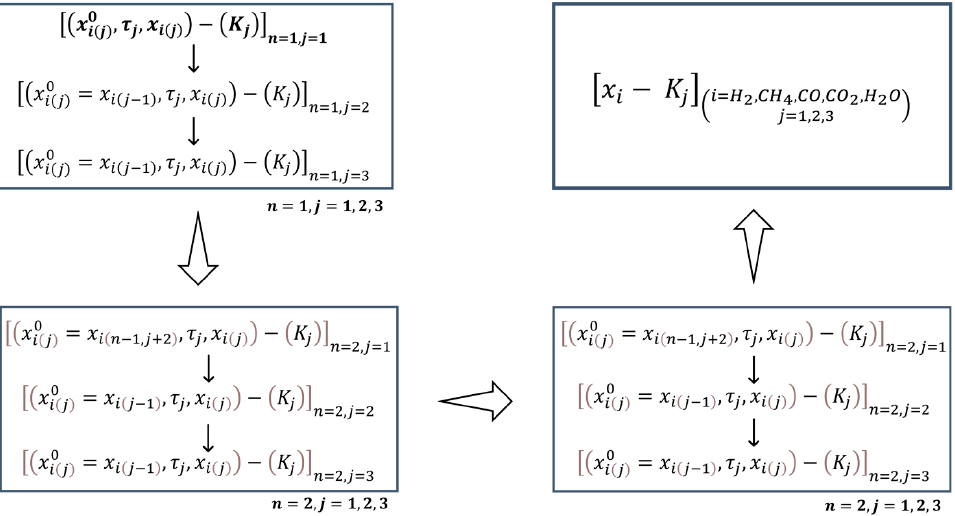
Figure 2. Numerical calculations of equilibrium composition x i ( i = H 2 , CO, CO 2 , CH 4 , H 2 O) for the process of steam reforming of a gaseous mixture (CH 4 /H 2 ), using parametric equations.